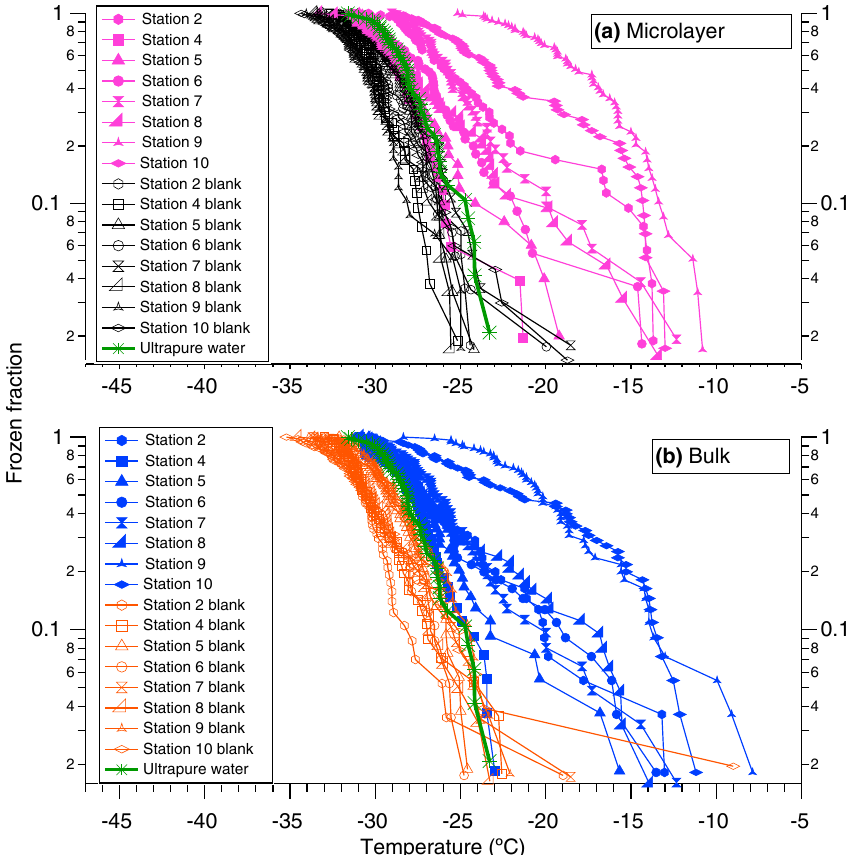
Figure 2. Fraction of droplets frozen (in the immersion mode) vs. temperature. Panels (a) and (b) correspond to the microlayer and bulk seawater, respectively. Each set of line and markers represents the results for three repeat experiments of a sample or blank, adding up to a total of between 45 and 60 freezing events in each set. Also included are the respective blank samples and ultrapure water. Each data point corresponds to a single freezing event in the experiments. All microlayer and bulk seawater freezing points have been corrected for freezing point depression to account for dissolved salts in seawater (Sect. 2.2.4). The uncertainty in temperature is not shown but is ± 0 . 3 ◦ C.